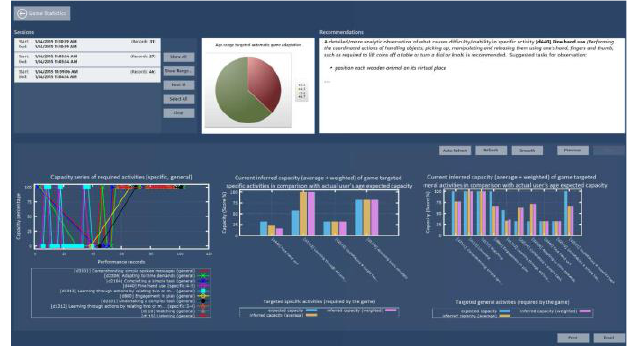
Figure 2. Max: Report produced while playing the Farm